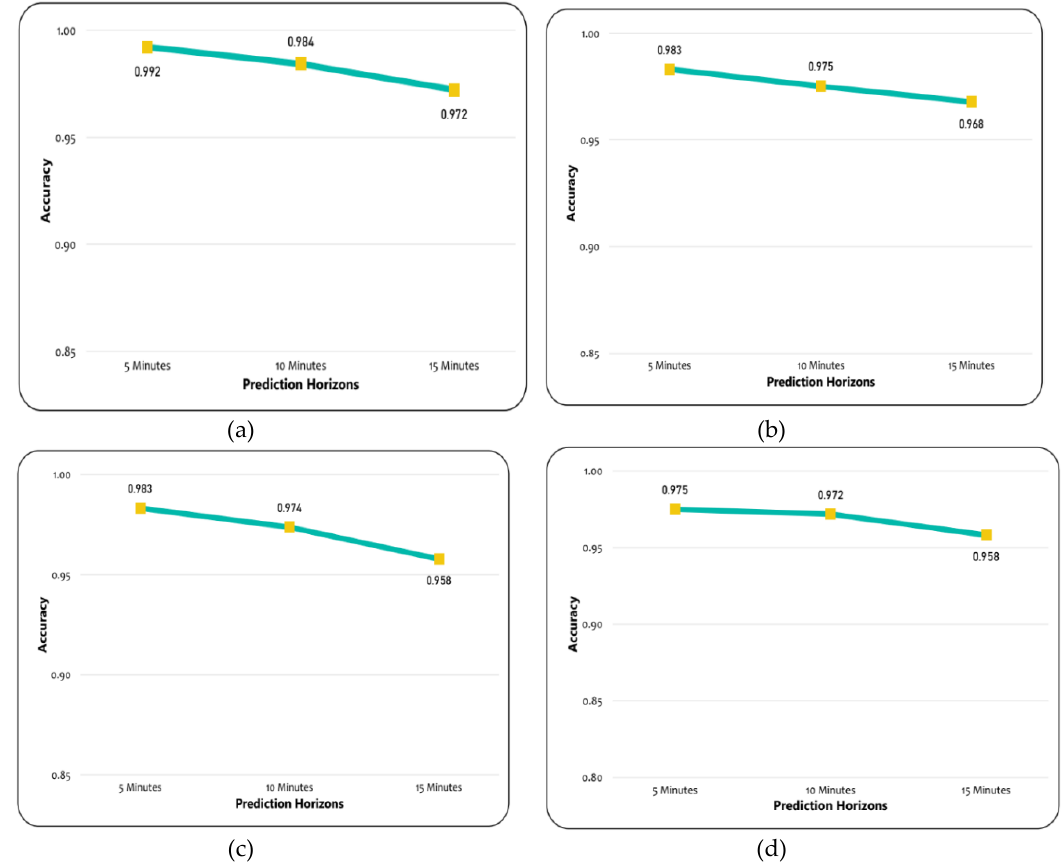
Figure 13. Model Comparison. ( a ) Accuracy for the decision jungles. ( b ) Accuracy for the LD-SVM. ( c ) Accuracy for the MLP. ( d ) Accuracy for the CN2 rule induction.